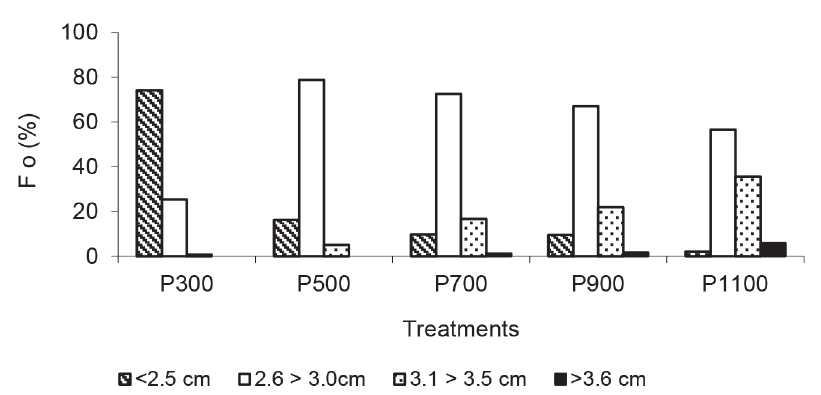
Figure 1 - Frequency of occurrence (Fo) of Hoplias lacerdae juveniles in different size classes at the end of the experiment.